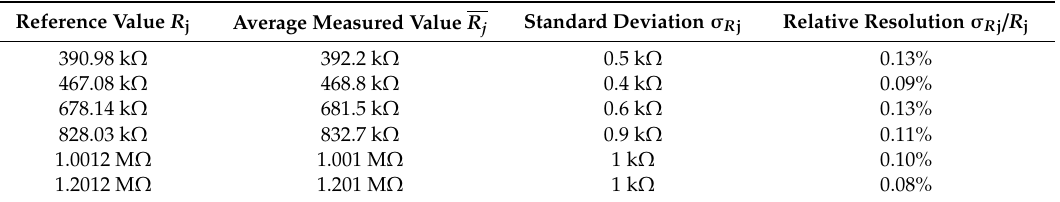
Table 1. Reference values R j , average values R j , standard deviations σ R j and relative resolution σ R j / R j estimated over N = 40 repeated measurements obtained with the system prototype.